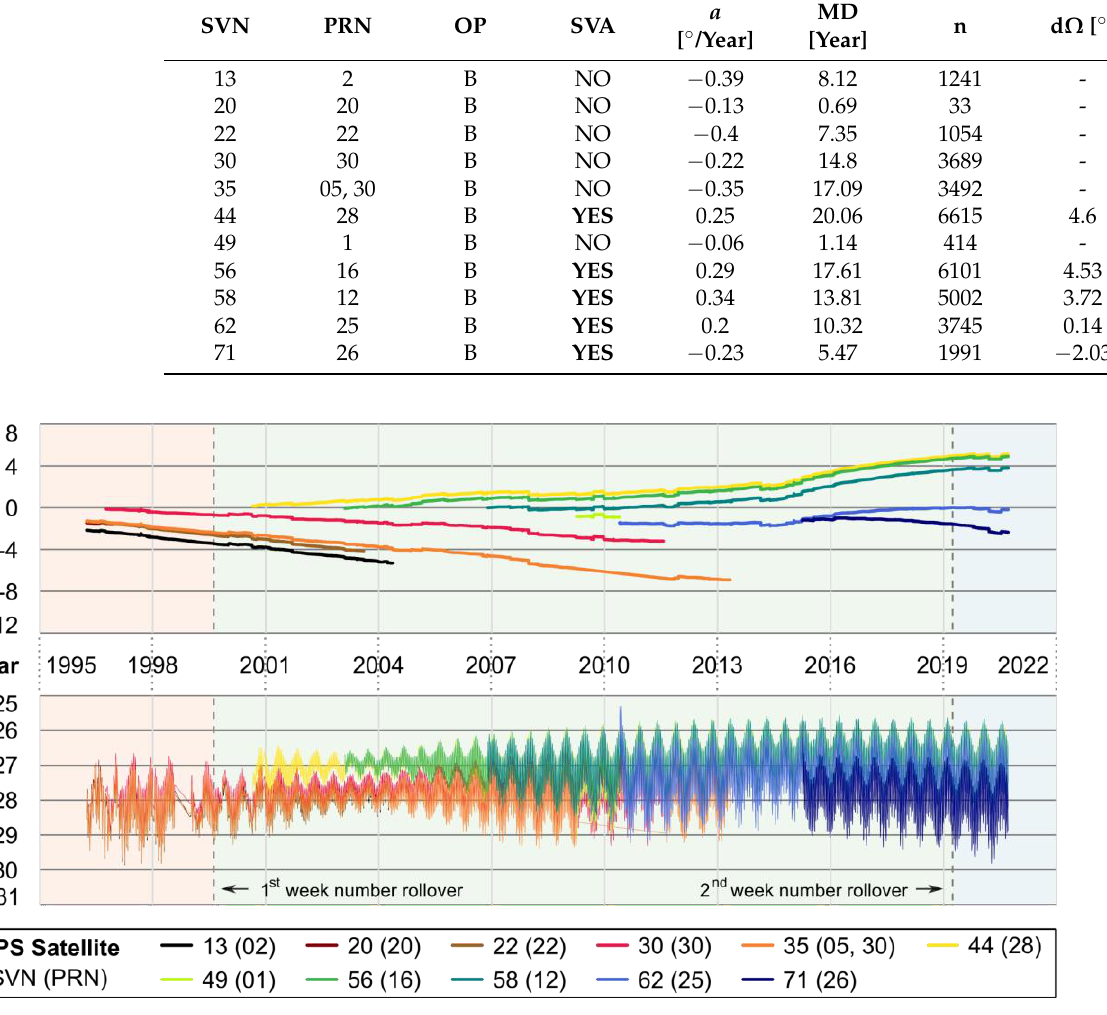
Figure A2. Separation of satellite ANs from the hex-LS-estimated position of the OP B AN with satellite dot(Ω) values.